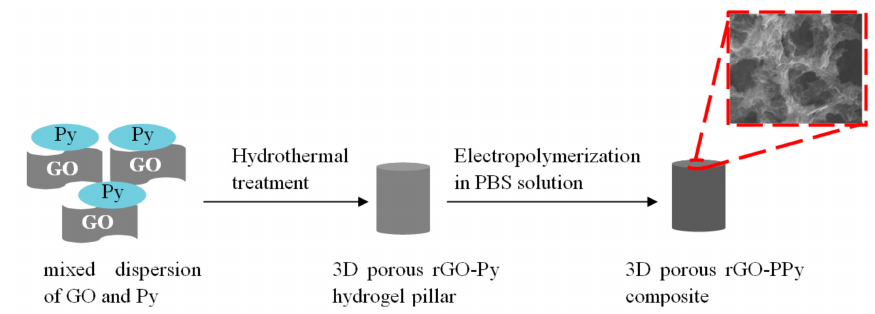
Figure 1. The scheme of preparation of the three-dimensional (3D) porous graphene-polypyrrole (rGO-PPy)